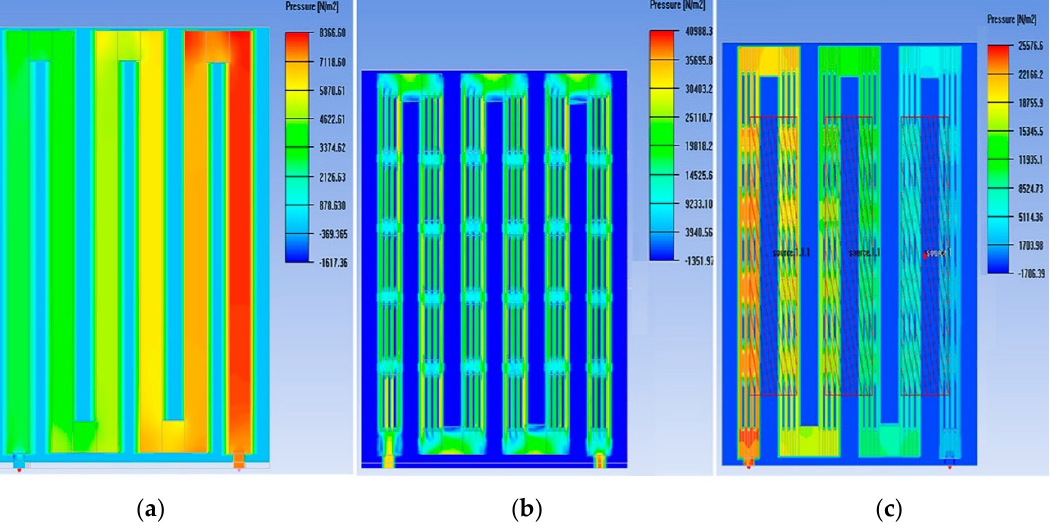
Figure 6. Comparison between pressure distribution cloud diagrams of three types of water-cooled plates. ( a ) No Spoiler Column. ( b ) Rectangular Spoiler Column. ( c ) Elliptical Spoiler Column.